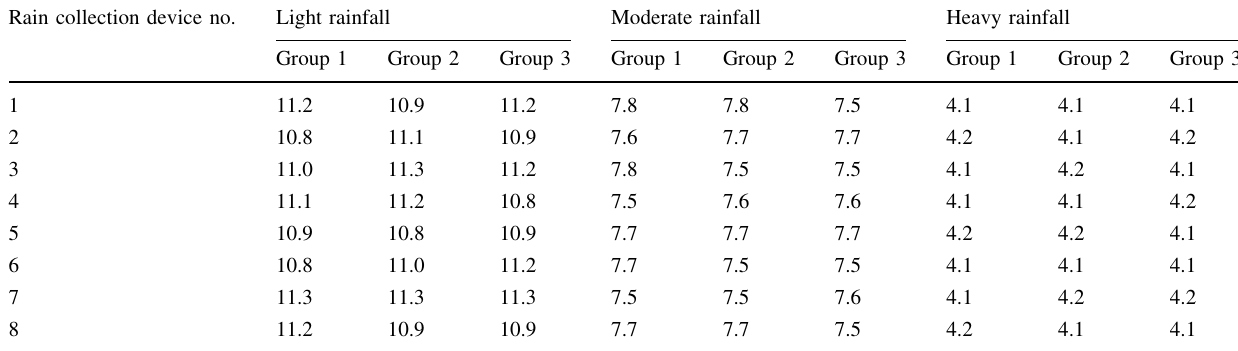
Table 3 Rainfall duration threshold for water–sand flow initiation Rainfall intensity Group no. Rainfall duration (min) Hysteresis time (s) Light rainfall Group 1